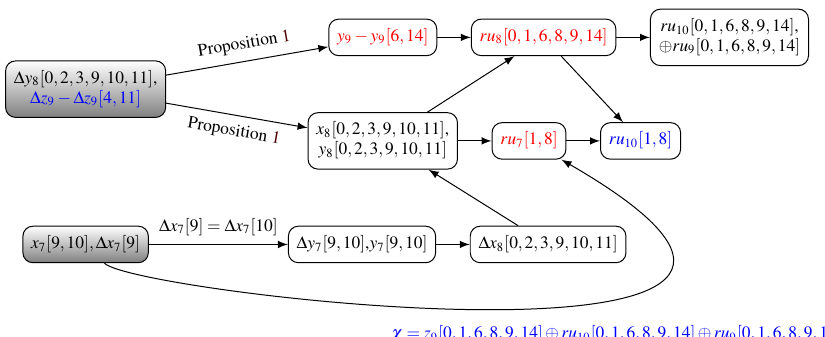
Figure 12: Constructions of Tables T i 2 12 values for each index in each table, respectively.